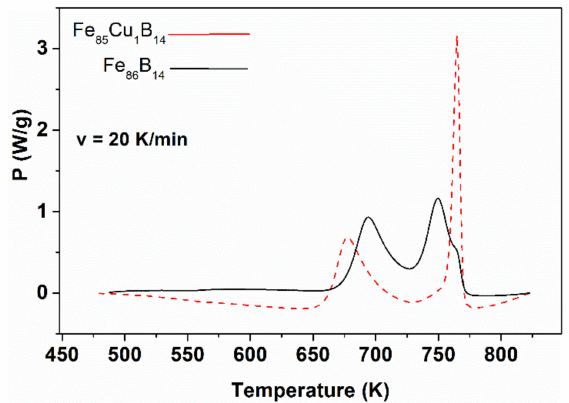
Figure 29. DSC thermograms for the decomposition of hypo-eutectic FeB 14 and FeB 14 Cu 1 glasses measured at a constant heating rate of 20 K / min. Adopted from [112], with permission from Elsevier,